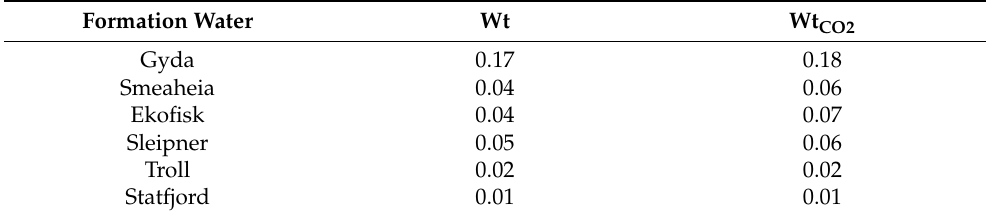
Figure 4. Images of graphite cathodes after polarization at 5 V, for 30 min in different reservoir waters with ( right ) and without ( left ) additional CO 2 . Table 3. Weight of the deposit (in grams) obtained from 200 mL of the different formation waters without and with CO 2 supply.